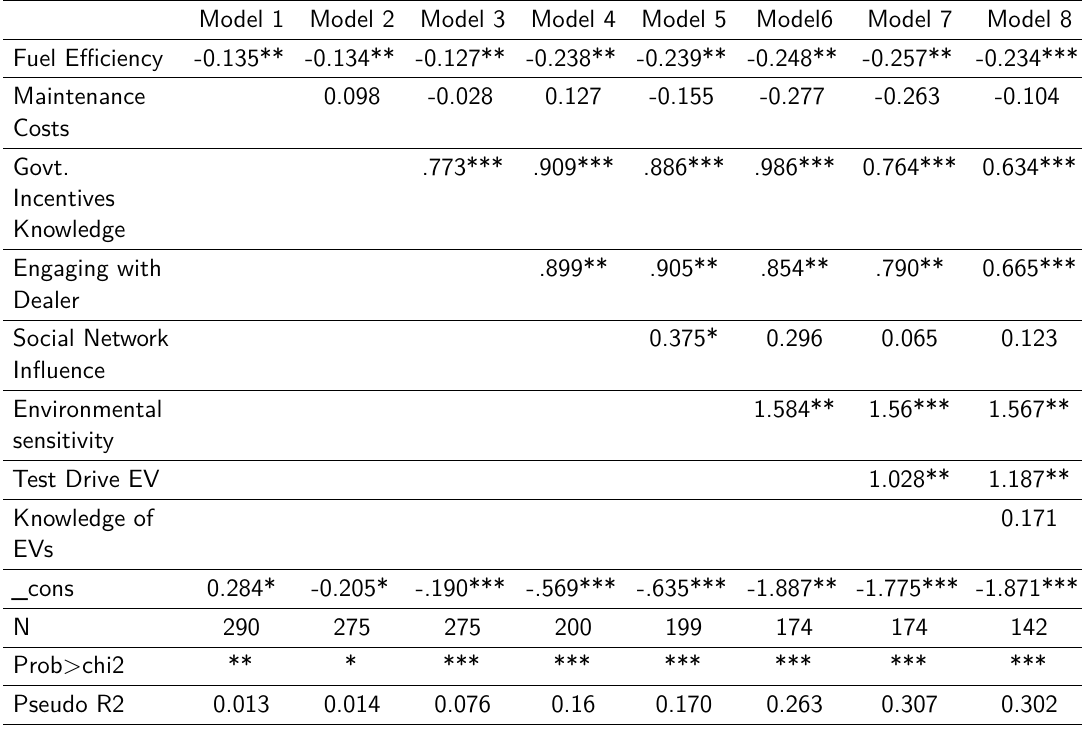
Table 6 . Multinomial logistic regression results between inferential